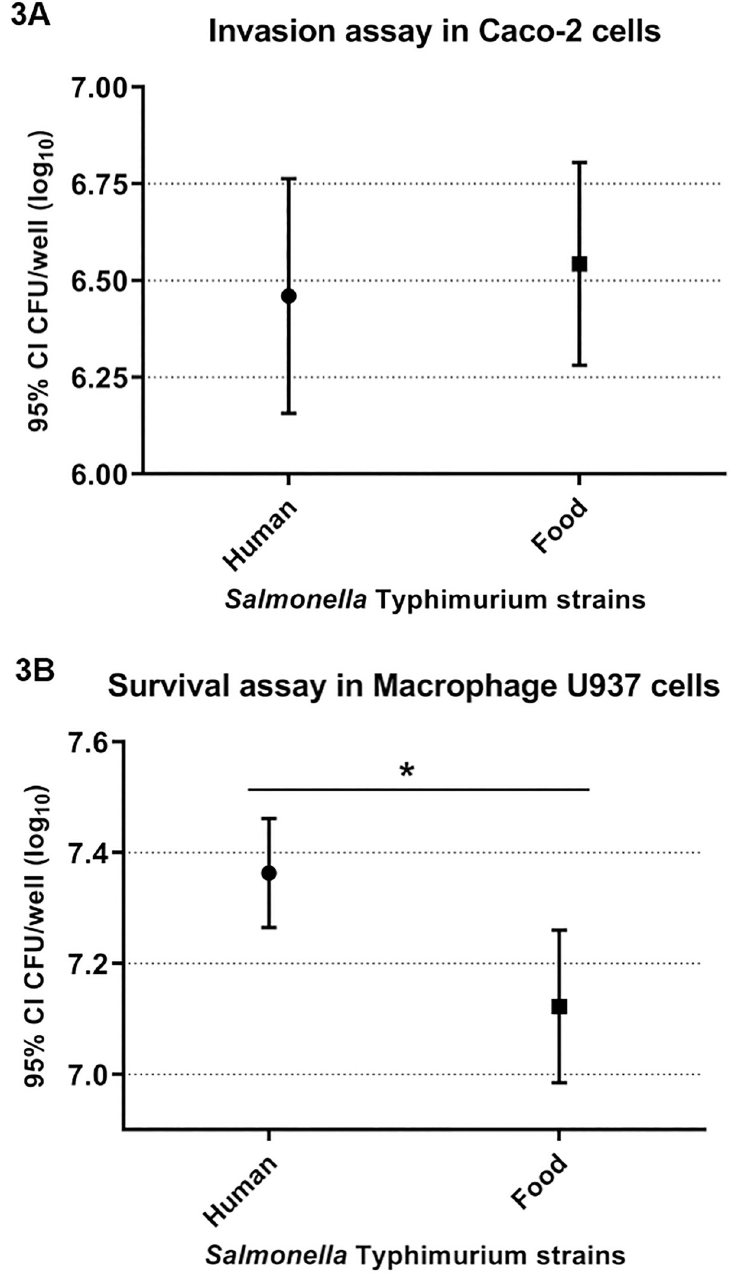
Fig 3. Comparison among the means of CFU/well (log 10 ) with 95% confidence interval (CI) of Salmonella Typhimurium strains isolated from humans and foods after the assays of Caco-2 epithelial cell invasion (A) and U937 human macrophages survival